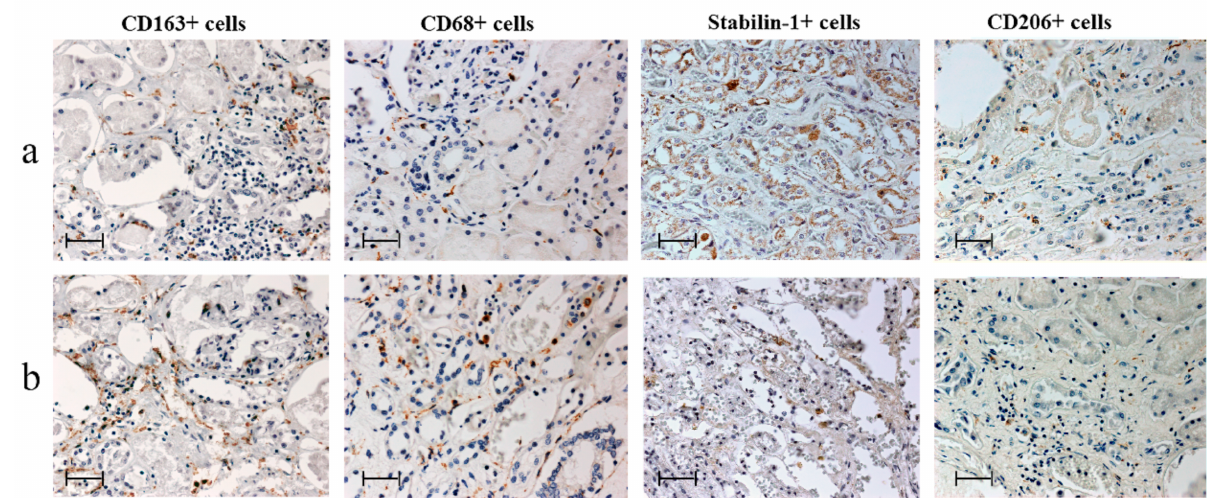
Figure 1. Changes in macrophage infiltration of kidneys according to the period of myocardial infarction (MI), immunohistochemistry, scale-bar 50 µ m. a —early period of MI ( n = 17), b —late period of MI ( n = 13).